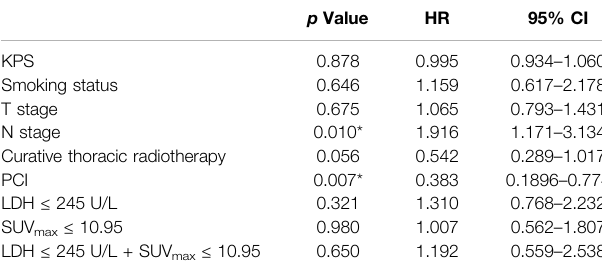
TABLE 6 | Univariate analysis of overall survival in 64 patients with ED